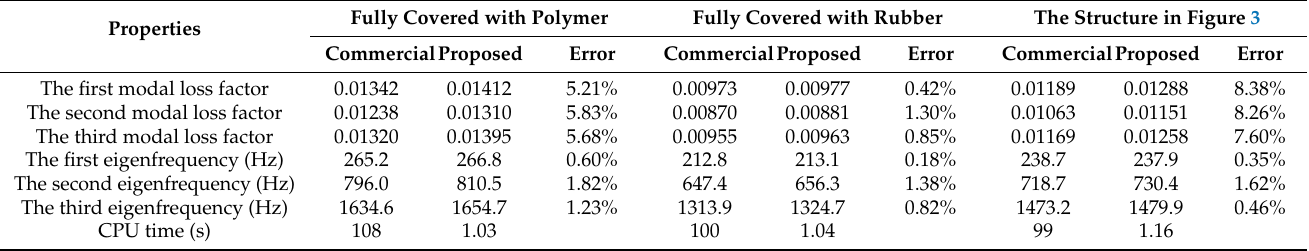
Figure 3. Comparison of the proposed model and commercial finite element tool Altair Hyperworks. ( a ) Full-scale model in Altair Hyperworks. ( b ) Microstructure. ( c ) The proposed multi-scale model. ( d ) Comparison of the displacement frequency response. Table 2. Comparison between the proposed model and commercial software Altair